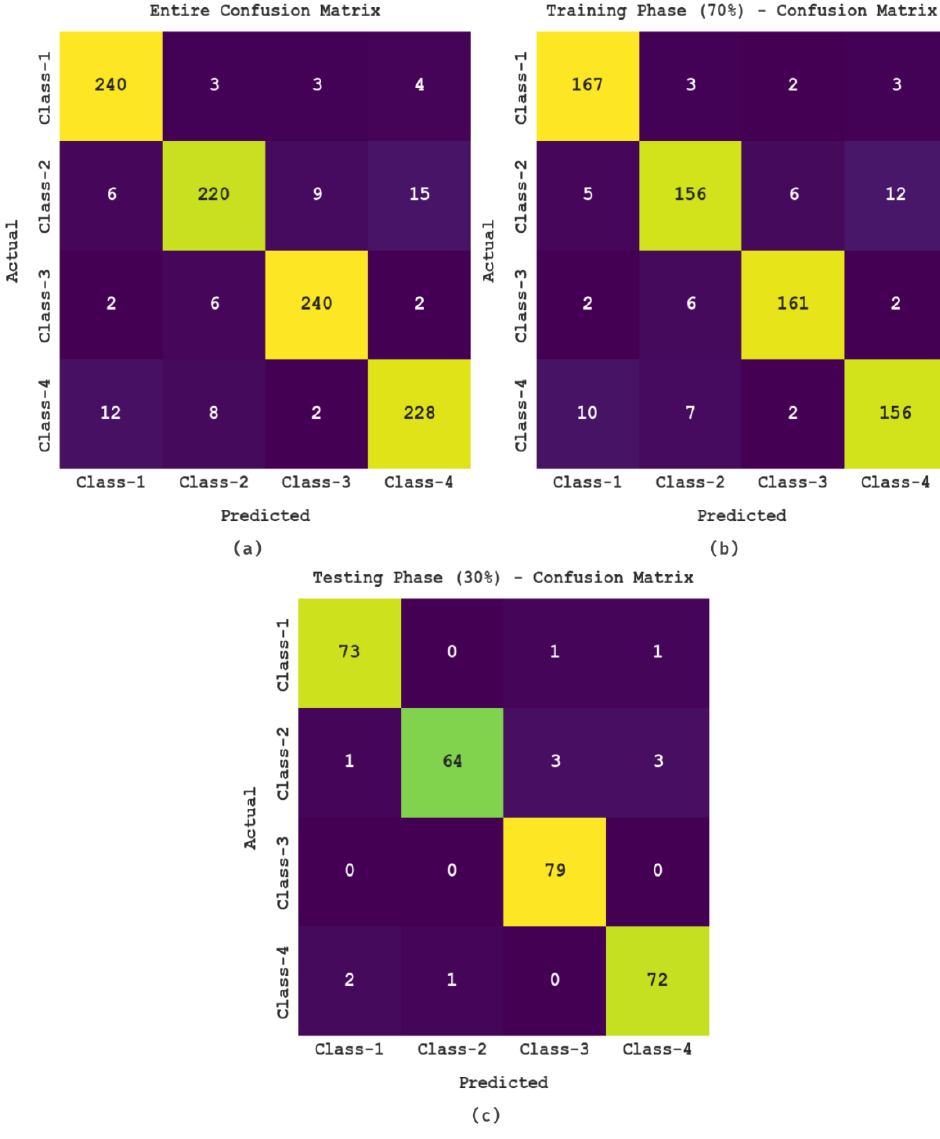
Figure 3. Confusion matrices of AOTL-CDA3S system ( a ) Entire database, ( b ) 70% of TR database, and ( c ) 30% of TS database.